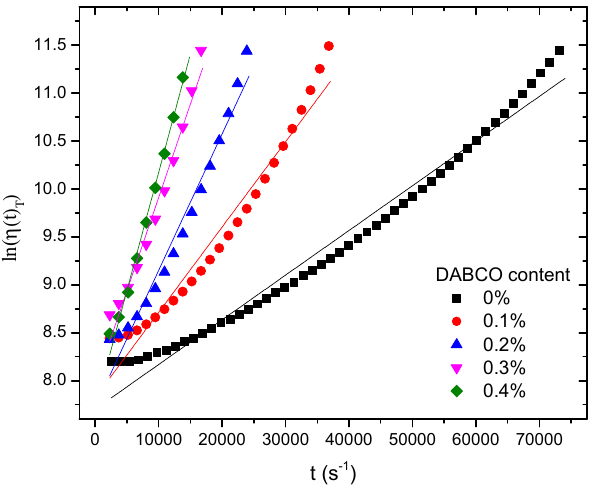
Figure 6. ln( η ( t ) T ) versus time for HTPB/HDI-trimer system in different mass fraction of the DABCO.